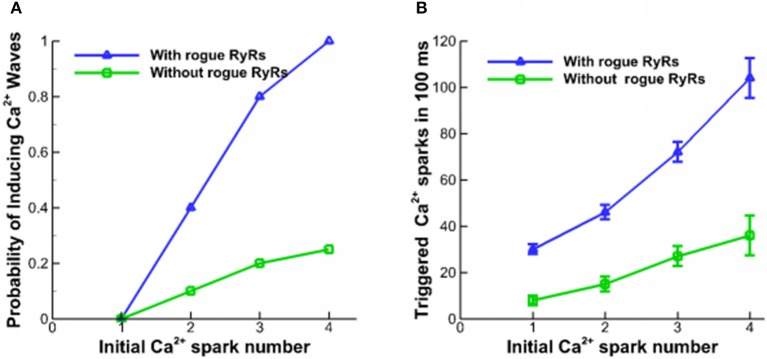
Properties of Ca2+ waves. (A) The probability of inducing Ca2+ waves triggered by different numbers of Ca2+ sparks. (B) The number of triggered Ca2+ sparks in 100 ms.